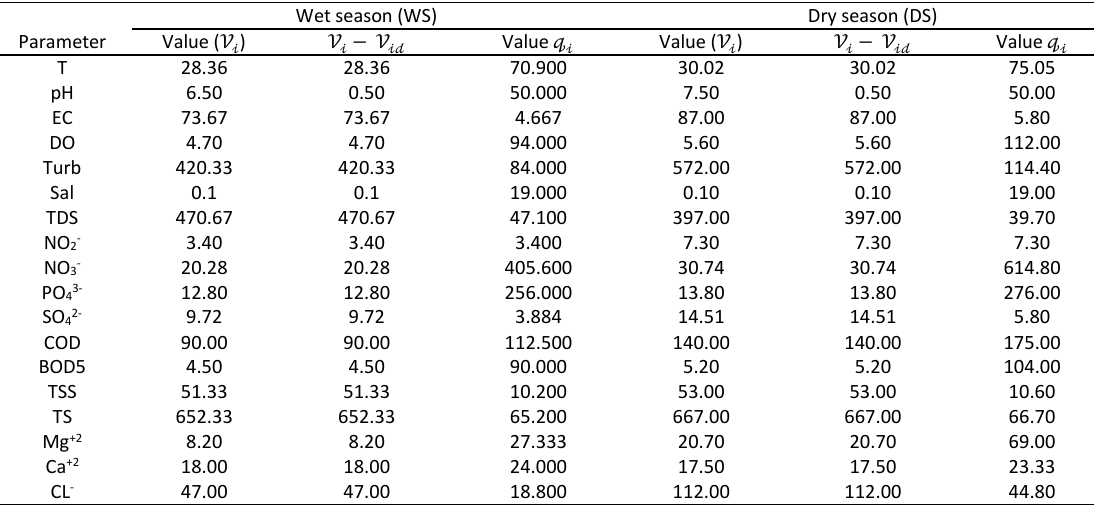
Table 5: Calculaon of numerator and denominator of quality rating Table 5: Calculation of numerator and denominator of quality